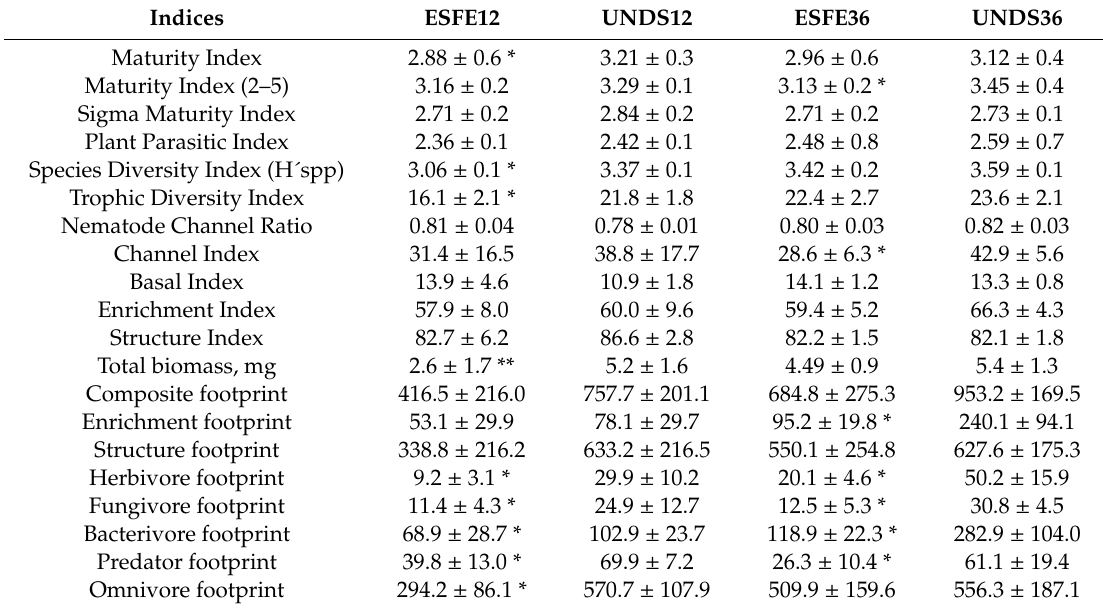
Table 7. Nematode community indices, biomass, and metabolic footprints associated with early successional forest ecosystem (ESFE) and windstorm undisturbed areas (UNDS) 12 and 36 months after event. Each data is an average of the individual plots and sampling date (mean ±